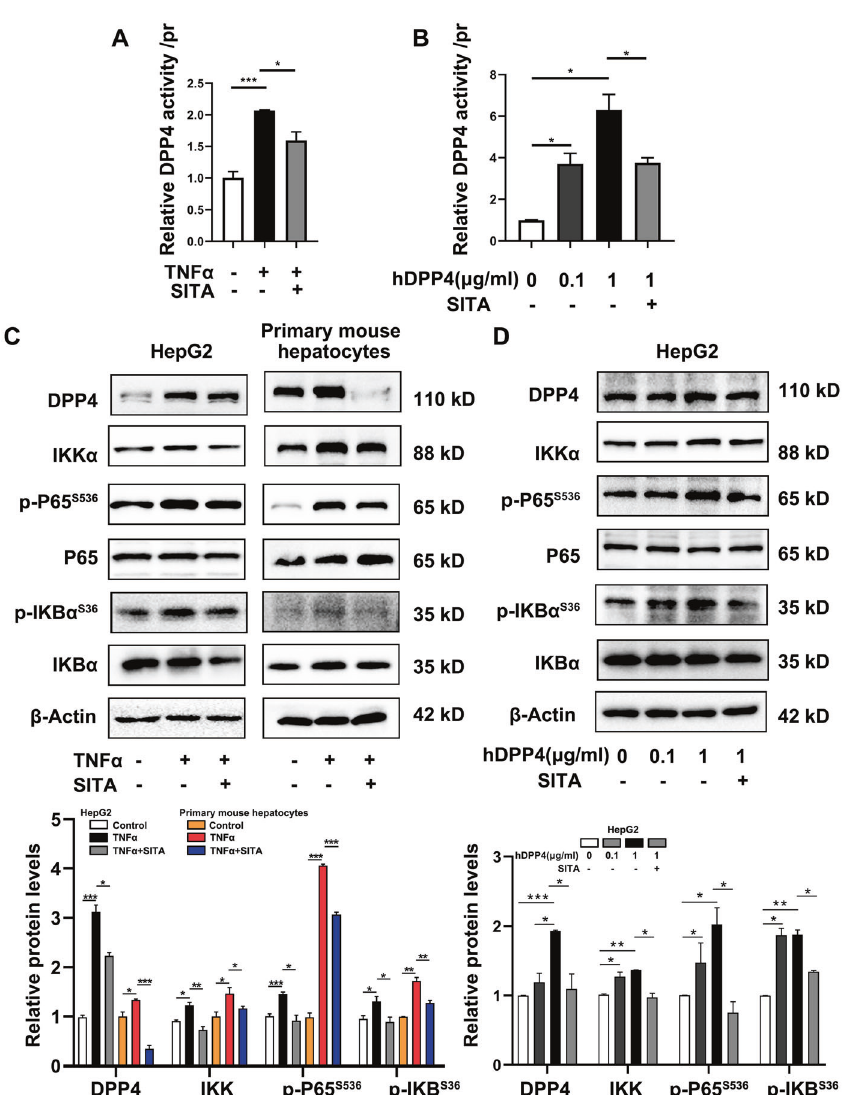
Fig. 1 Sitagliptin prevents TNF α -activated NF κ B signaling pathway. A After 24 h TNF α (20 ng/ml) or TNF α + SITA (100 μ M) treatment, DPP4 activity in HepG2 cells were detected. B HepG2 cells were co-stimulated recombinant human DPP4 (hDPP4, 0.1 and 1 μ g/ml) protein with sitagliptin for 24 h, after that the activity of DPP4 was determined. C Western blots and quantitative analysis of the effects of sitagliptin on the protein levels of DPP4, IKK α , p-P65 S536 , P65, IKB α , and p-IKB α S36 in TNF α or TNF α + SITA-treated HepG2 cells and primary mouse hepatocytes. D Western blottings and quantitative analysis of the effects of different concentrations of hDPP4 on the protein levels of DPP4, IKK α , p-P65 S536 , P65, IKB α , and p-IKB α S36 in HepG2 cells. The results are presented as mean ± SEM of three independent experiments; * P < 0.05, ** P < 0.01, *** P <